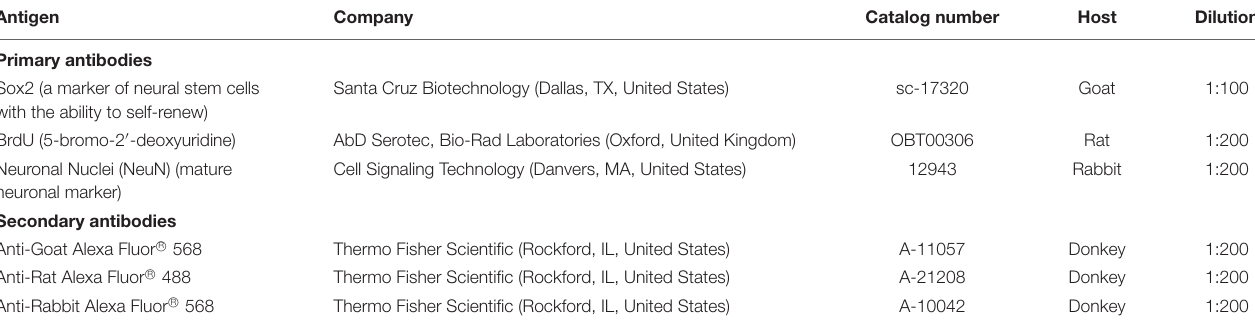
TABLE 2 | Antibodies used for